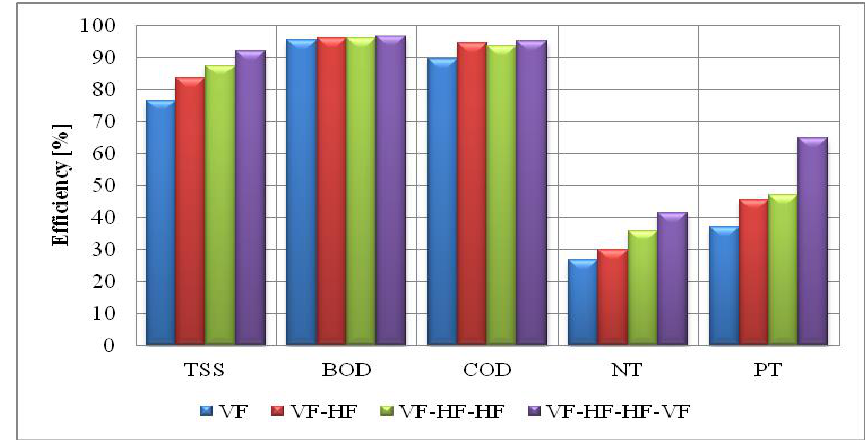
ffi ciencies in the investigated Figure 4. Mean pollutant removal efficiencies in the investigated system . Figure 4. Mean pollutant removal e